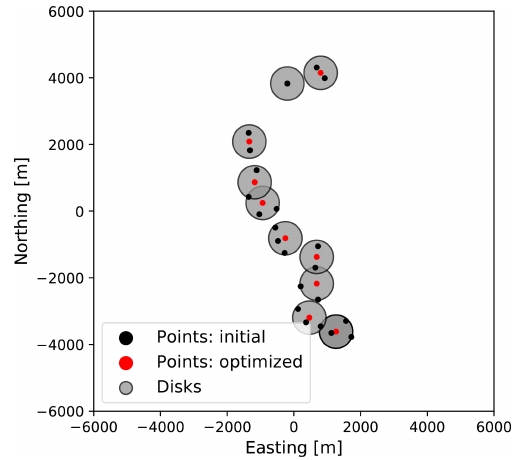
Figure 15. Measurement locations for the Turkish site: black dots – wind turbine positions, gray circles – disks covering wind turbine positions, red dots – optimized measurement positions (i.e., disk